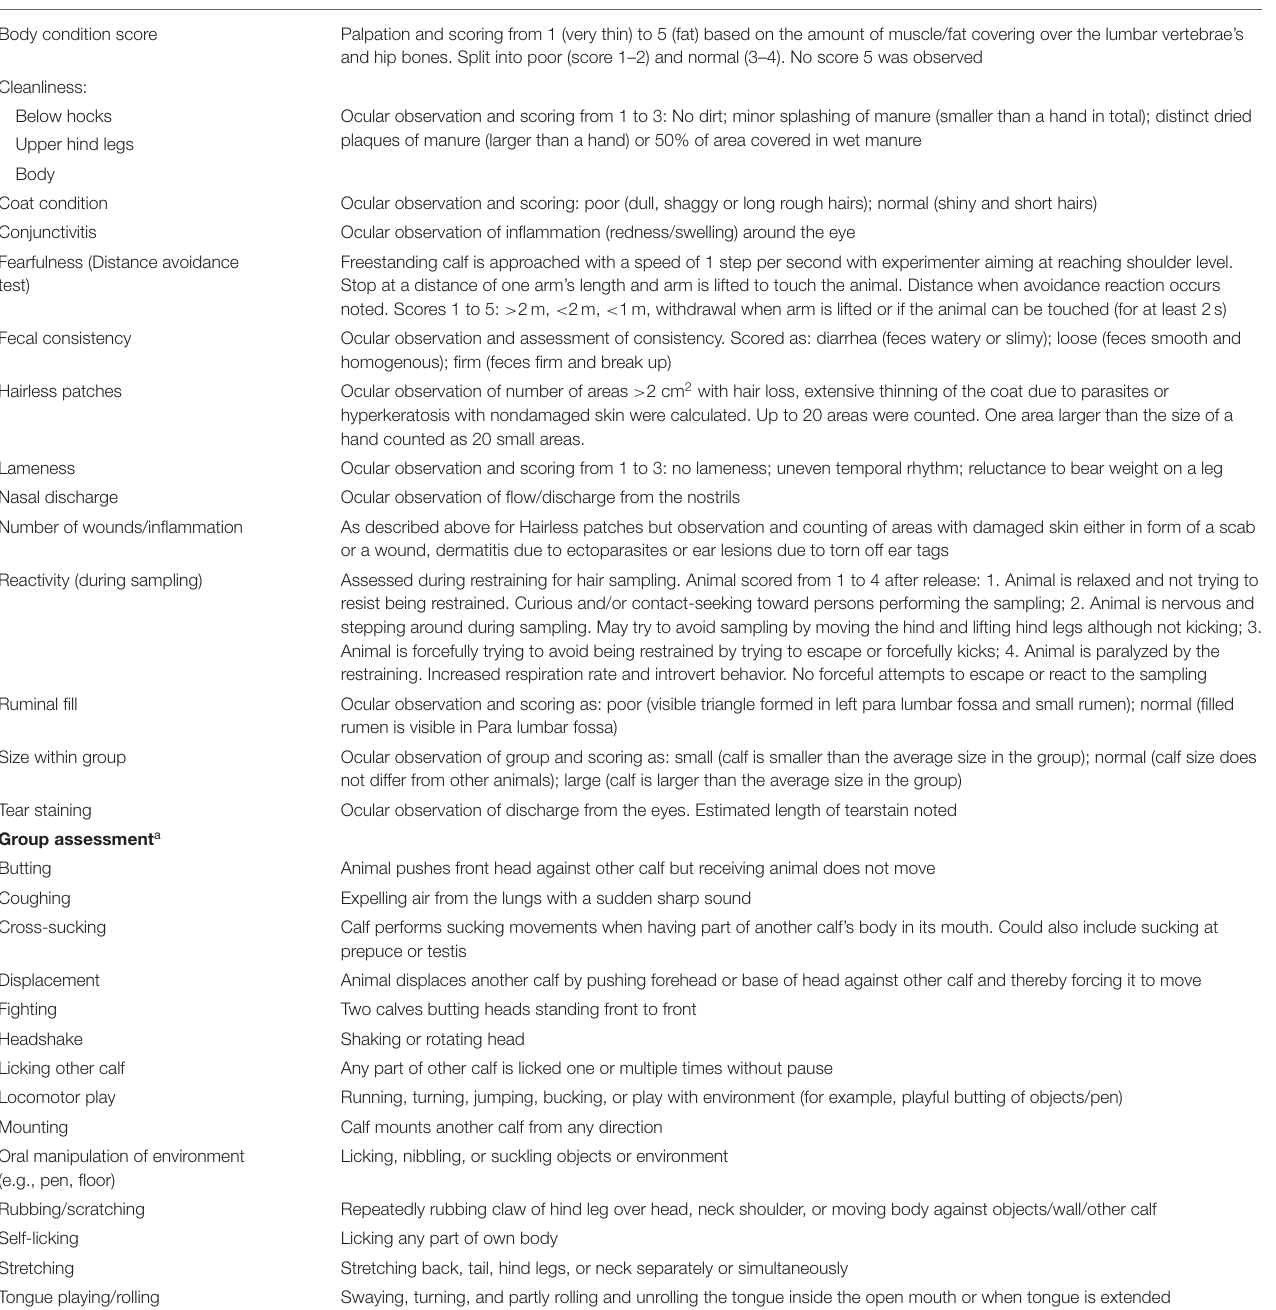
TABLE 1 | Description of indicators used for welfare assessment of the calves. Individual